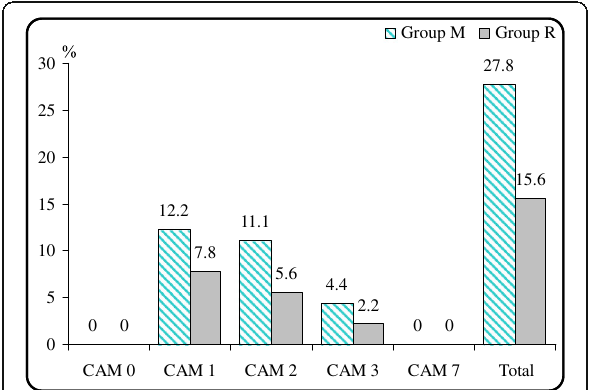
Fig. 2 Confusion Assessment Method ( CAM) score